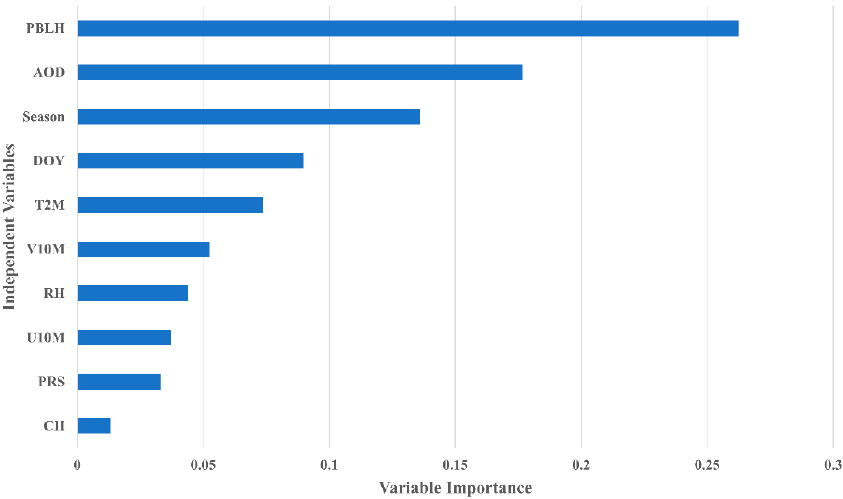
Figure 7. The average top 10 variable importance of independent variables.